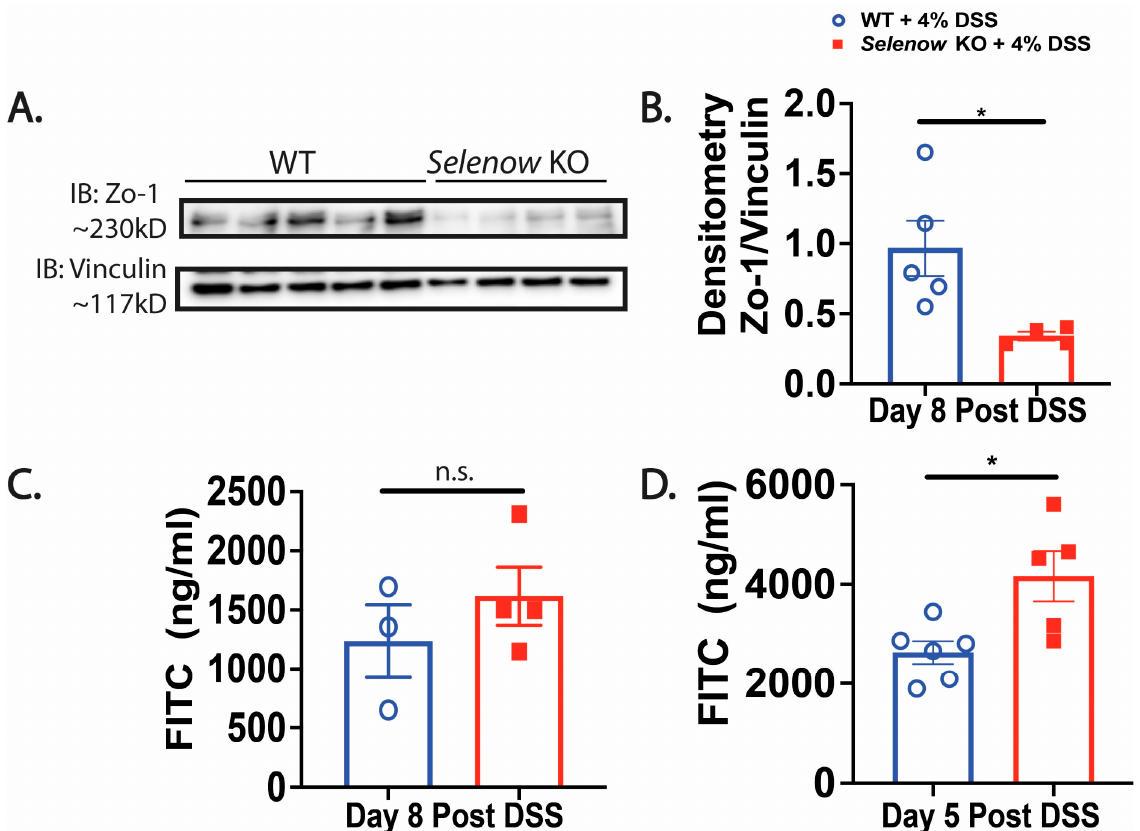
Figure 4. Loss of Selenow exacerbates colonic epithelial barrier disruption following injury. ( A ) Rep- resentative immunoblot of Zo-1 and ( B ) quantification of Zo-1 from colonic lysates of WT and Selenow KO mice at day 8 post DSS (WT = 5 mice; Selenow KO = 4 mice). ( C ) FITC concentration in serum of WT and Selenow KO mice at day 8 post DSS (WT = 3 mice; Selenow KO = 4). ( D ) FITC concentration in serum of WT and Selenow KO mice at day 5 post DSS (WT = 6 mice; Selenow KO = 5). Data indicate mean ± SEM. ( B – D ) Unpaired non-parametric Mann–Whitney test. * p < 0.05, n.s., not significant.